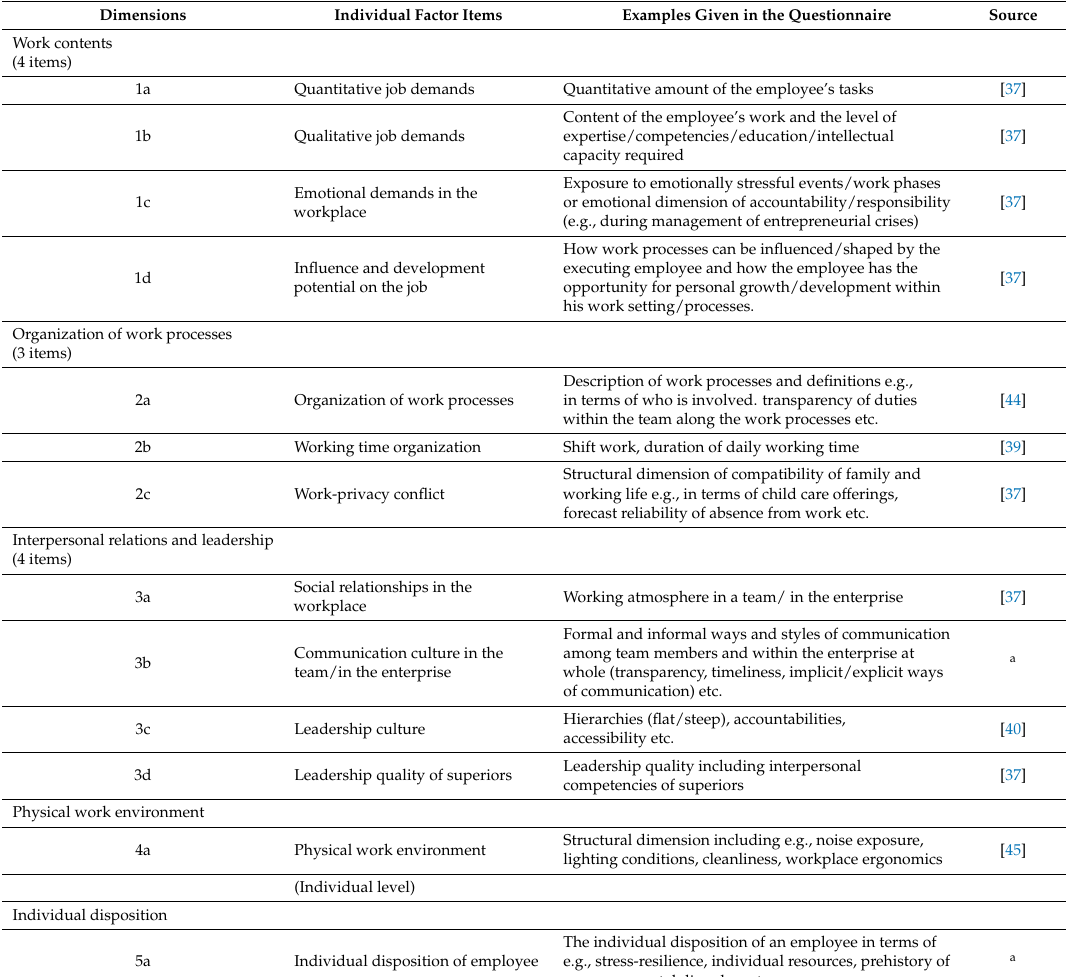
Table 3. Items and dimensions of applied